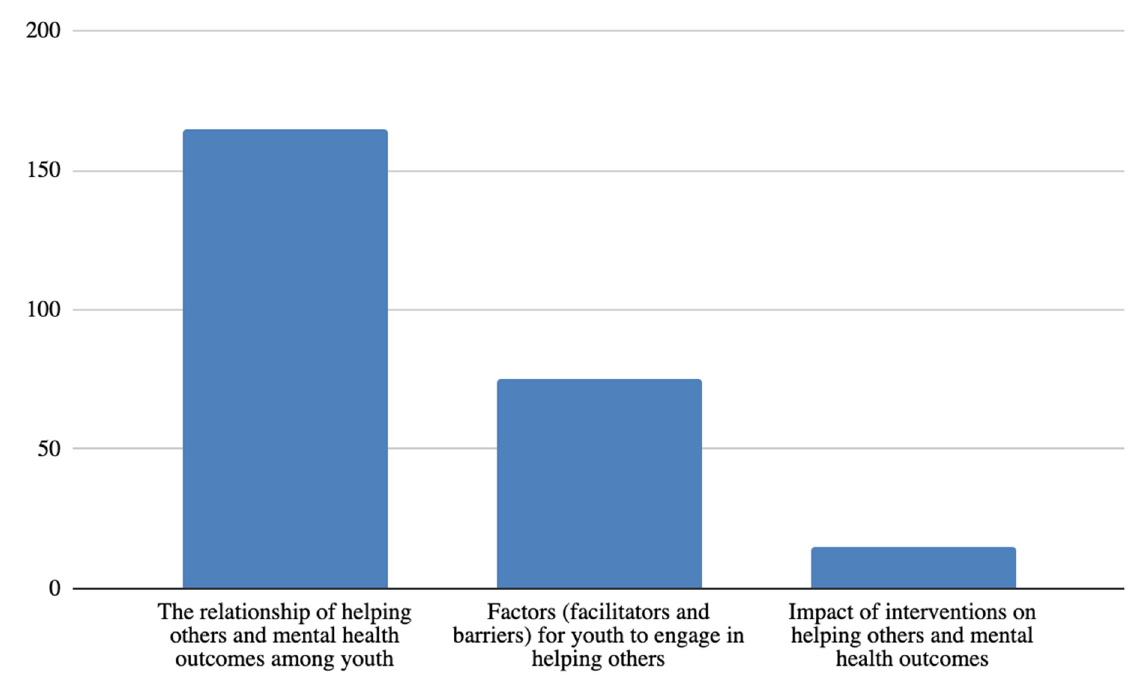
Figure 3. Frequency of Themes in the